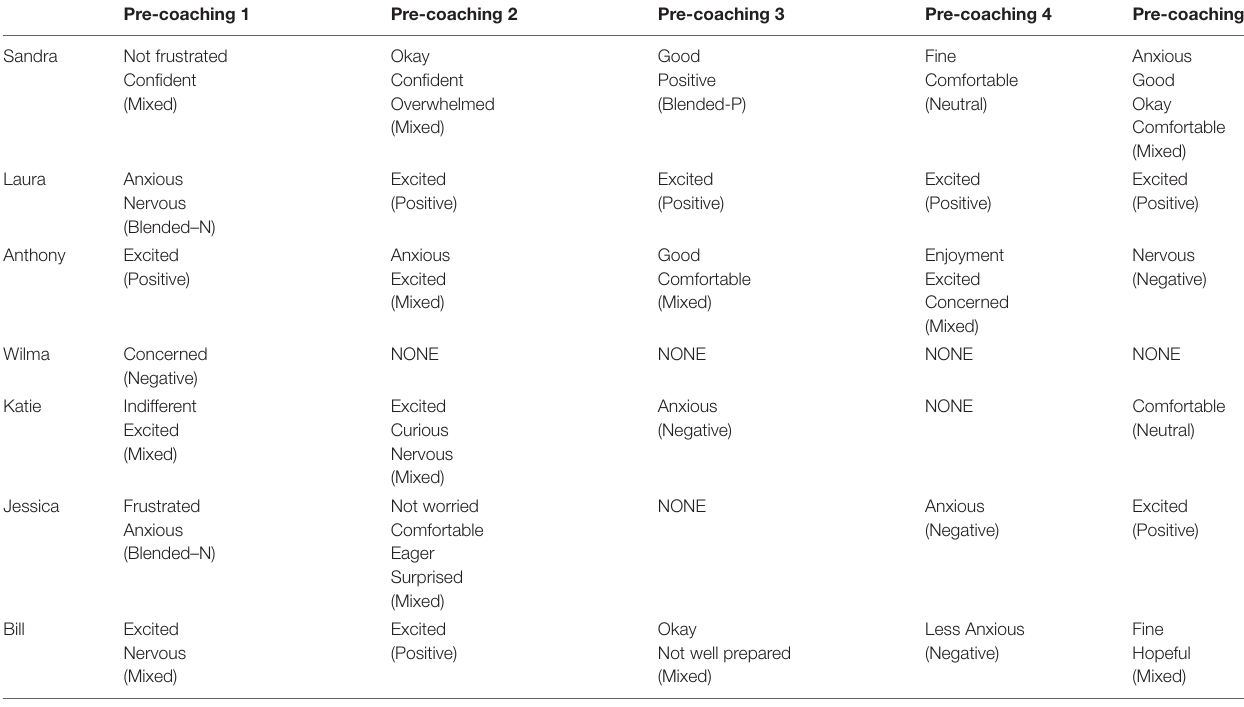
TABLE 2 | Teachers’ descriptions of their emotions during the pre-coaching conversations.